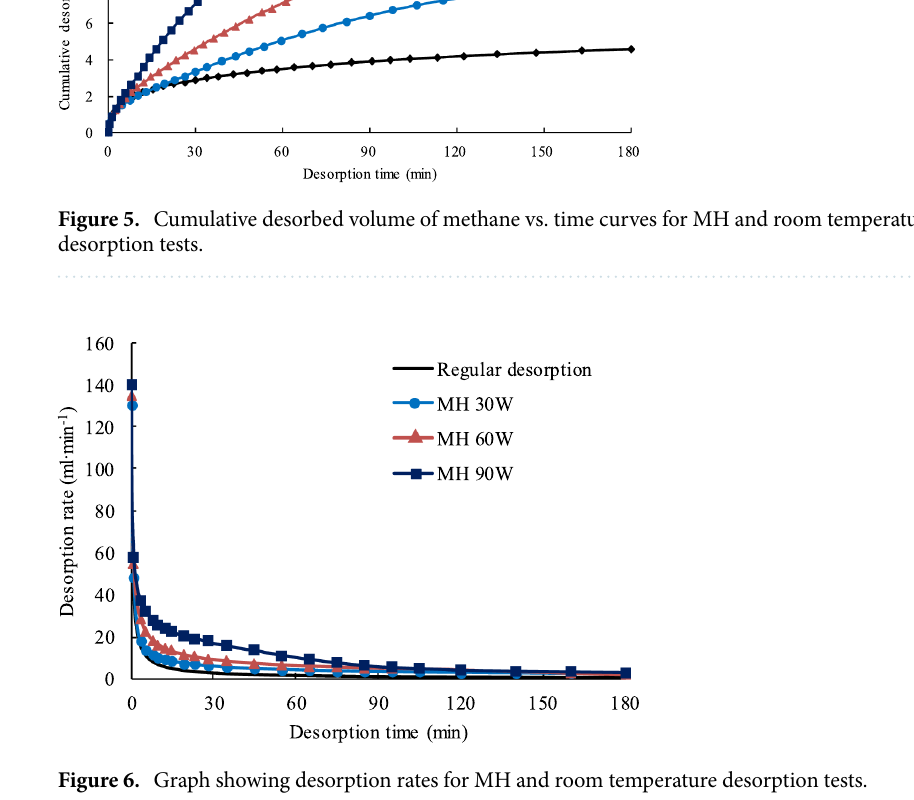
Figure 6. Graph showing desorption rates for MH and room temperature desorption